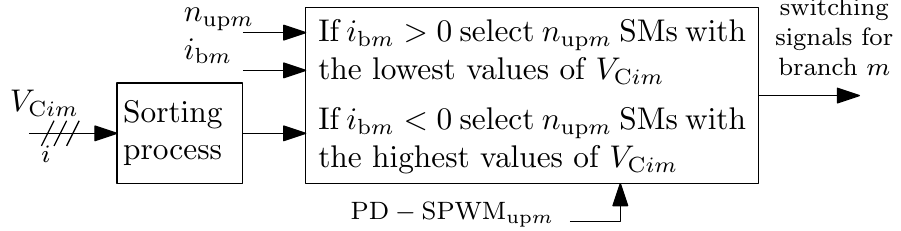
Figure 7. PD–SPWM VBA